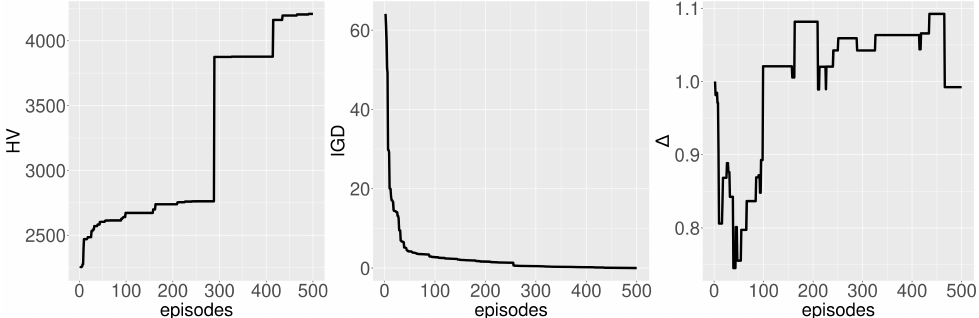
Figure 9. Evolution of the front during the training according to HV, IGD and Δ